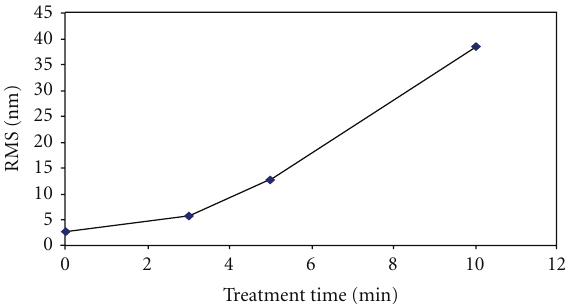
Figure 7: Variation of RMS value with respect to treatment time.